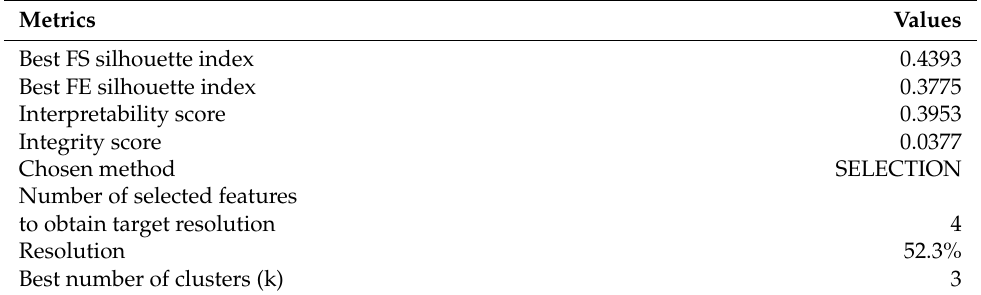
Table 8. Algorithm results using interpretability-oriented = 0.9, integrity-oriented = 0.1 and target- resolution = 50%.